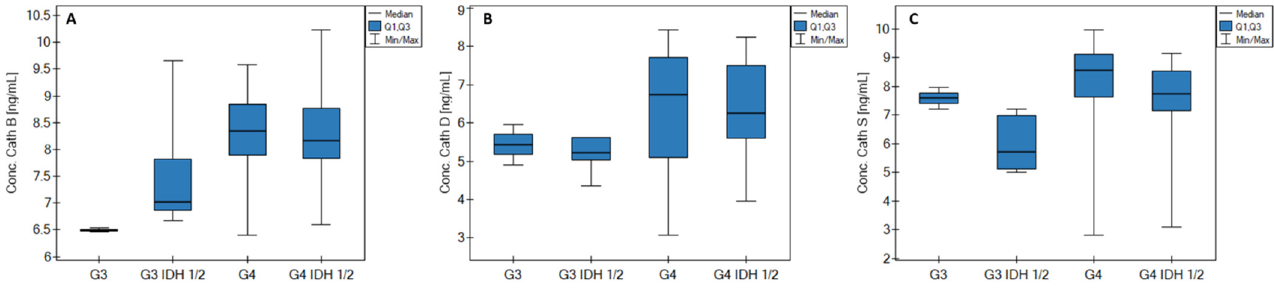
Figure A3. Effect of IDH status on concentrations ( A ) Cath B; ( B ) Cath D; ( C ) Cath S.